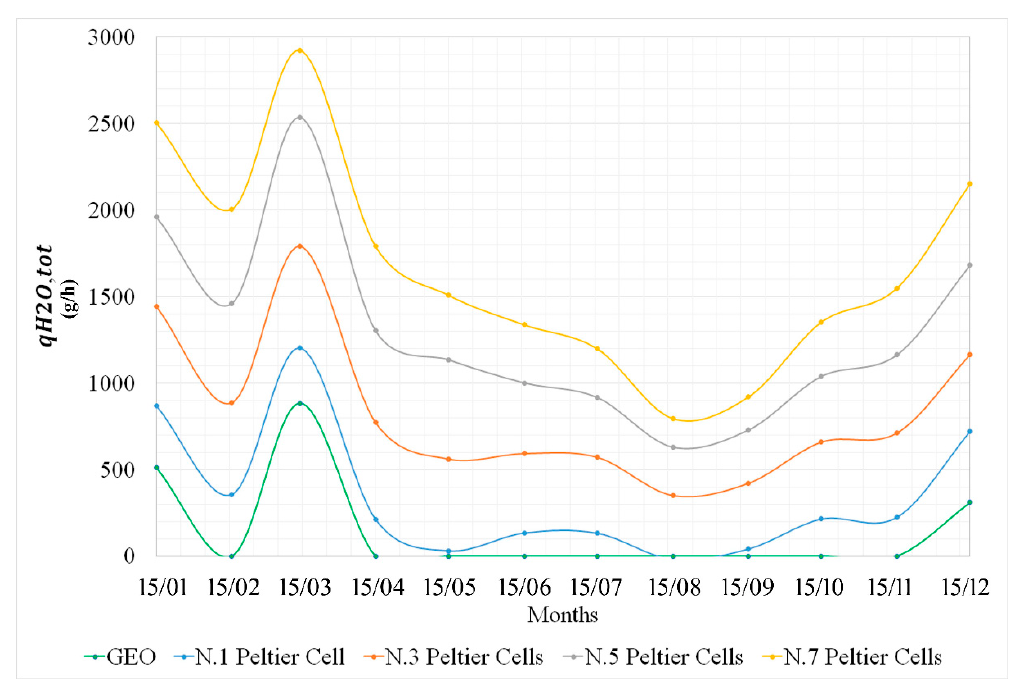
Figure 10. Annual overview of the total condensed water.